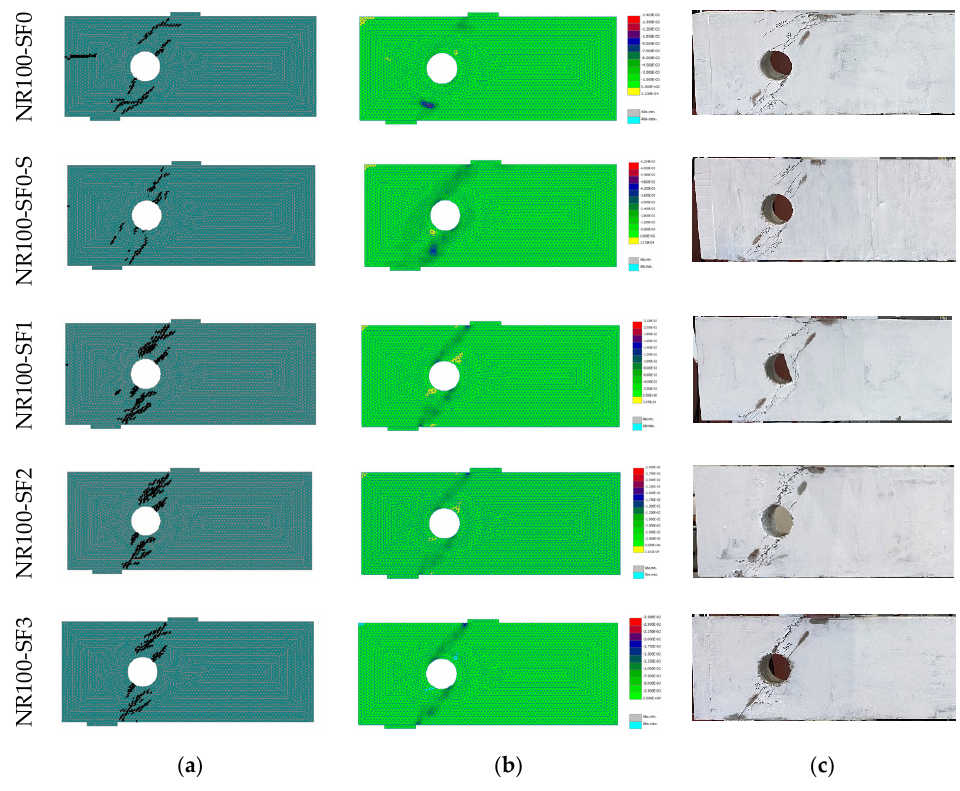
Figure 15. Crack patterns and principal strains: ( a ) numerical crack patterns; ( b ) minimum principal strains; and ( c ) experimental crack patterns.